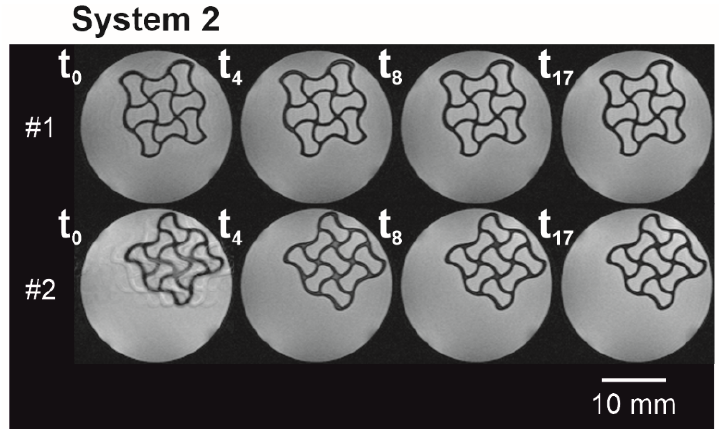
Figure 3. Auxetic structures in System 2 in MRI grayscale images with a field of view of 25 × 25 mm² at distinct time points. The MRI measurements’ settings were optimized towards an increased buffer-to- hydrogel contrast ( n =